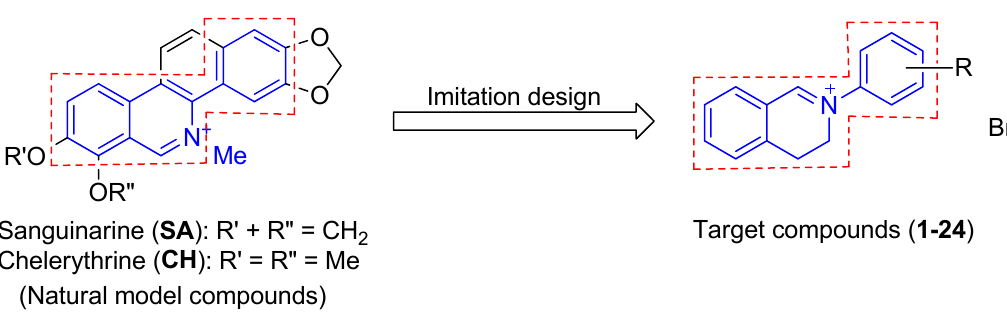
Figure 1. Structures of the target compounds and their model